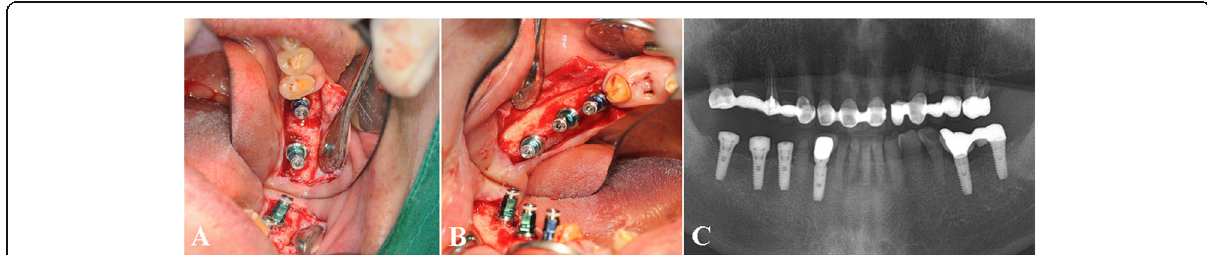
Fig. 6 A case of multiple implants placed in the posterior mandible. Intraoperative view of the #36, 37 ( a ) and #45, 46, 47 implants ( b ), postoperative panoramic view of the multiple implants in the mandible ( c